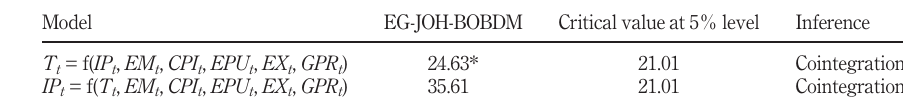
results: break in both intercept and trend